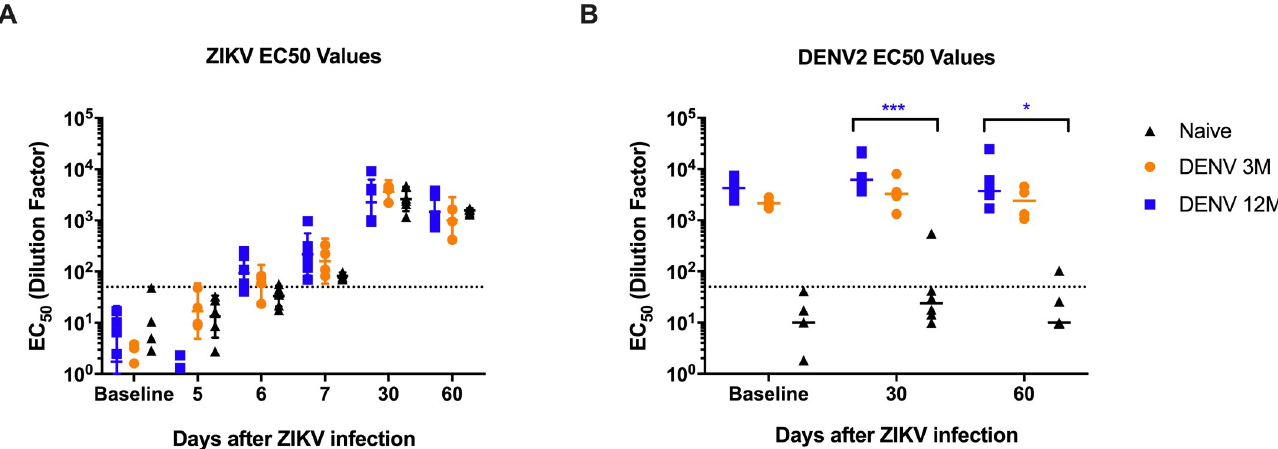
Fig 3. Geometric mean titers of dengue and ZIKV neutralizing antibodies. The 50% effective concentration of neutralizing antibodies was determined. Animals from cohort 1 are shown in blue, animals from cohort 2 are shown in orange and na ï ve animals from cohort 3 are shown in black in all panels. Dotted line indicates the limit of detection for the assay. Non-neutralizing sera were assigned a value of one-half of the limit of detection for visualization and calculation of the geometric means and confidence intervals. (A) EC50 values of neutralizing antibodies against ZIKV after ZIKV infection. (B) EC50 values of neutralizing antibodies against DENV2 after ZIKV infection. Statistically significant differences among groups were calculated by two-way ANOVA using Tukey’s multiple comparisons test ( � P < 0.05 and ��� P � 0.001). Statistically significant differences among groups were calculated by two-way ANOVA using Tukey’s multiple comparisons test ( � P < 0.05, �� P < 0.001, ��� P � 0.001 and ���� P < 0.0001). Colored stars represent a significantly different group, while colored lines represent the group that it is compared to.